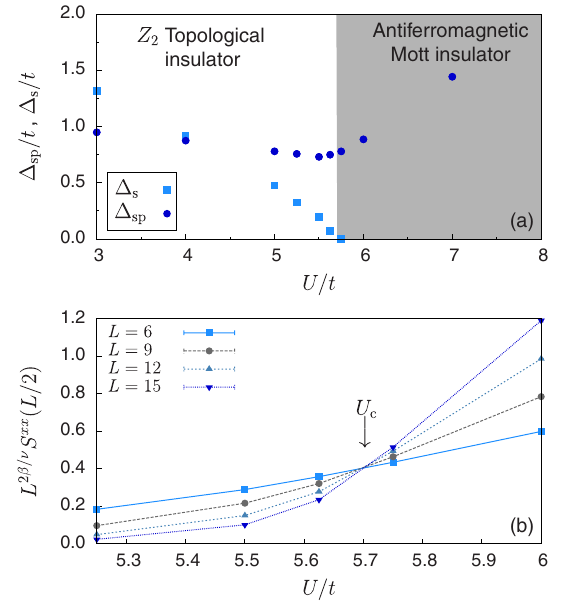
ð q ¼ 0 Þ and single-particle gap FIG. 4. (a) Spin gap (cid:1) s q ¼ K Þ in the thermodynamic limit as a function of the (cid:1) sp ð Hubbard repulsion U , at T ¼ 0 ( (cid:4)=t ¼ 0 : 2 , (cid:5) ¼ 0 ). (b) Scaling of S xx ð L= 2 Þ using the critical exponents of the 3D XY model, z ¼ 1 , (cid:10) ¼ 0 : 6717 ð 1 Þ , and (cid:6) ¼ 0 : 3486 ð 1 Þ [52]. The intersection =t ¼ 5 : 70 ð 3 Þ . The lattice size is L (cid:4) L . gives the critical point U c Error bars are smaller than the